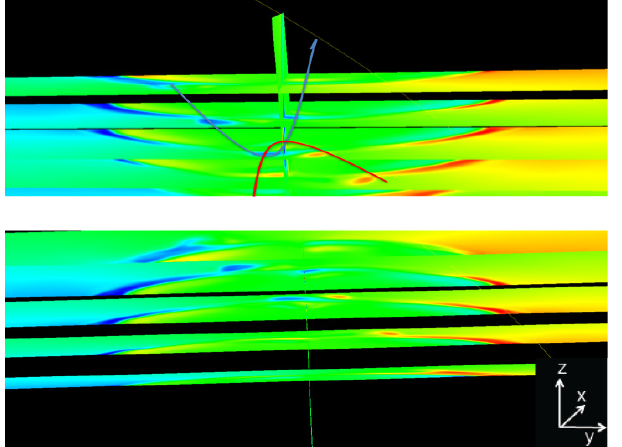
Fig. 13. Magnetic topology at t = 0 for positive z cuts at z = 0 . 6 and 1 R E (first and middle plots), showing the X points. The third plot shows a zoom of the X point region at z = 1 R E . Colors are related to magnetic topology as red, closed; yellow, connected to north; green, connected to south; and blue, solar wind. Arrows indicate flow velocity.